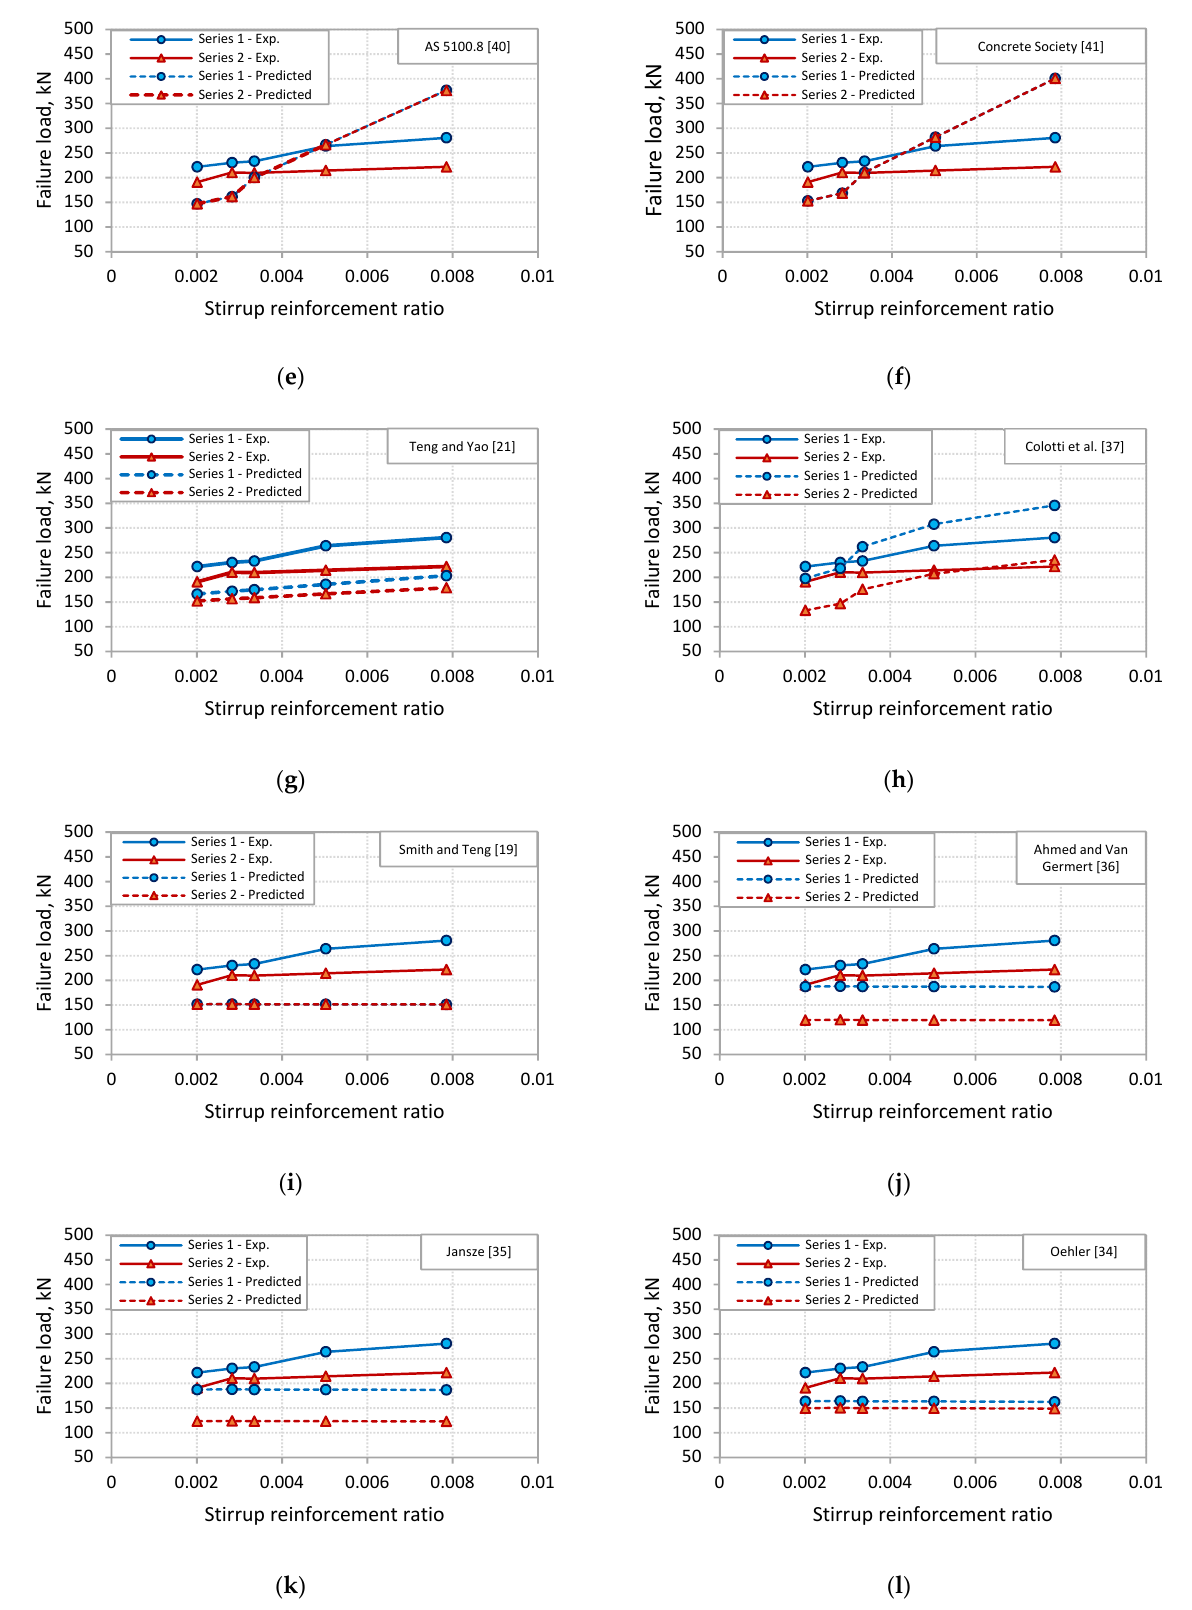
Figure 13. Comparisons of experimental versus predicted values for shear-based models: ( a ) El-Sayed et al. [14]; ( b ) Al- Ghrery et al. [15]; ( c ) fib Bulletin 90 [38]; ( d ) ACI 440.2R [39]; ( e ) AS 5100.8 [40]; ( f ) Concrete Society [41]; ( g ) Teng and Yao [21]; ( h ) Colotti et al. [37]; ( i ) Smith and Teng [19]; ( j ) Ahmed and Van Germert [36]; ( k ) Jansze [35]; ( l ) Oehler